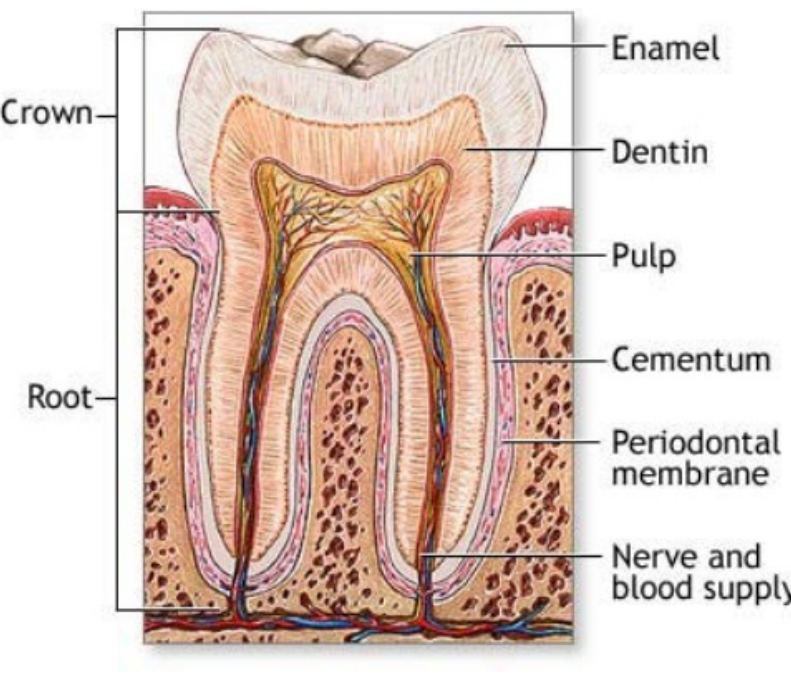
Figure 8. A schematic drawing of a tooth. Other very good graphical sketches of the mammalian tooth structure, including the hierarchical levels, are available in Refs.